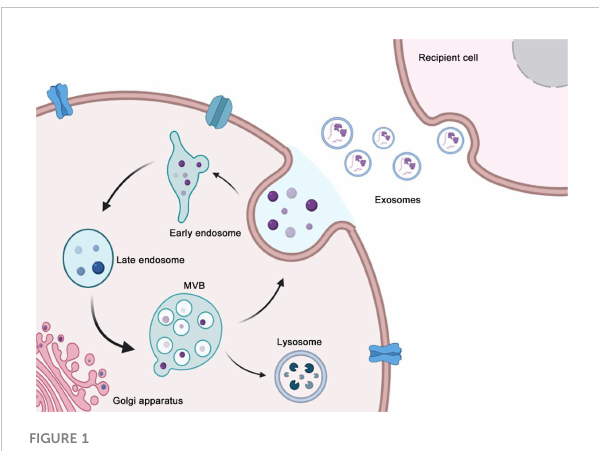
FIGURE 1 The process of exosome biogenesis and secretion. The biogenesis of exosome begins at early endosome formation through endocytosis at the plasma membrane, and then the invagination of the plasma membrane of LSEs forms ILVs that are ultimately secreted as exosomes. In the end, MVBs fuse with the plasma membrane to release exosomes. Ectosome originates from the outward budding and fi ssion of the plasma membrane, subsequently, the nascent ectosomes are released into the extracellular